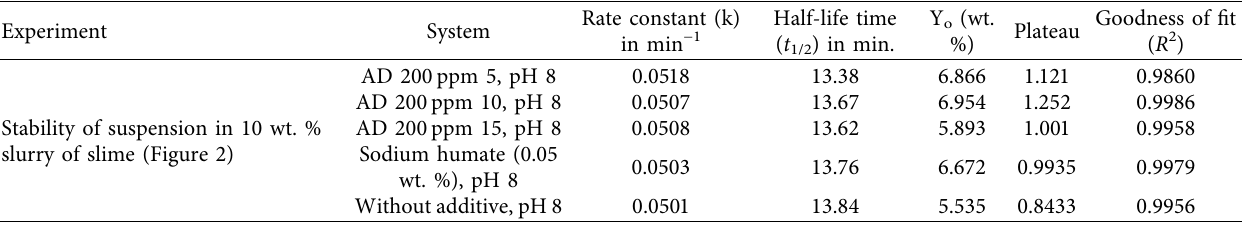
Table 4: Values of the parameters of equation (1) for beneficiation of 10 wt. % slurry of fines. Experiment System Stability of suspension in 10 wt. % slurry of fines (Figure